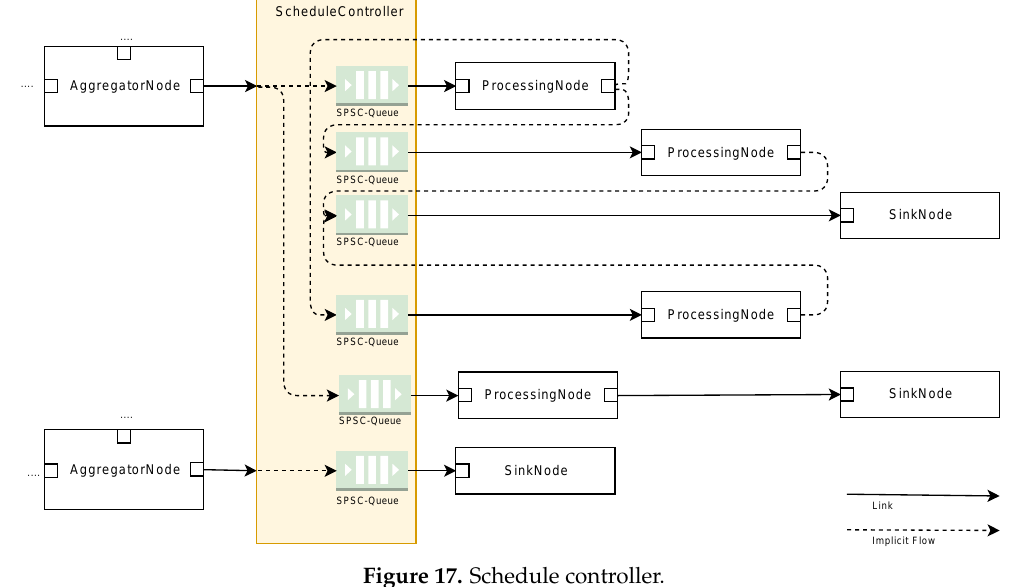
Figure 17. Schedule